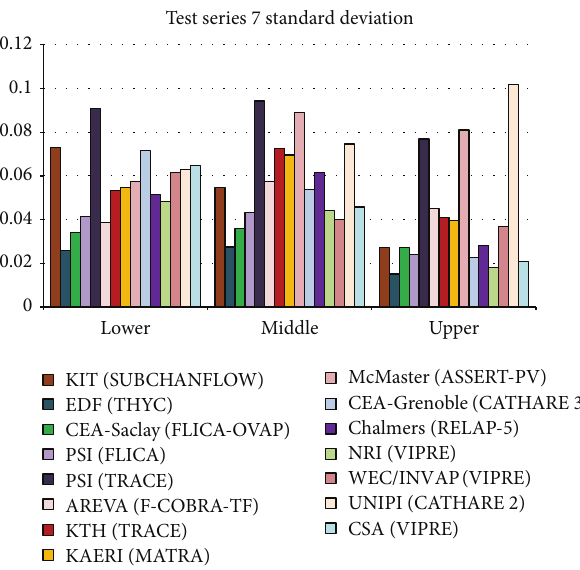
Figure 30: Test series 8 void fraction standard